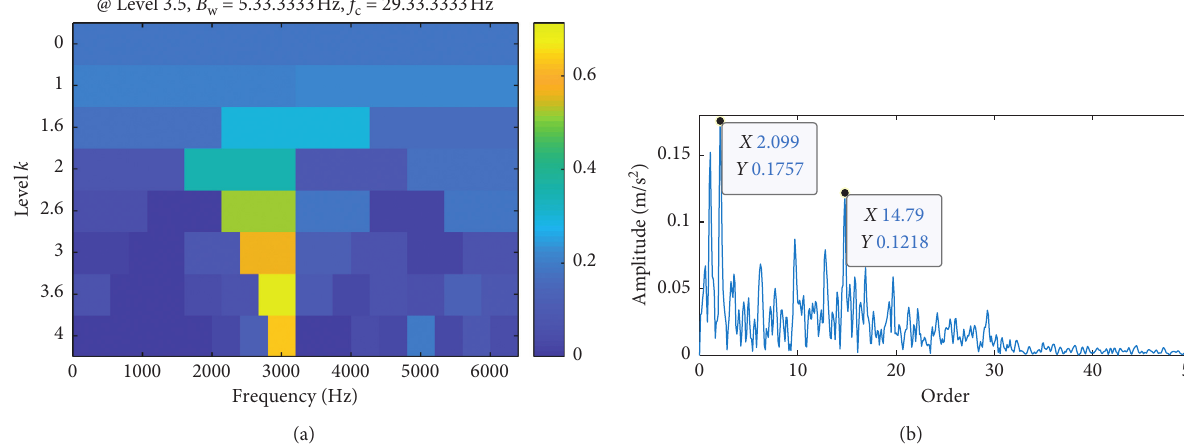
Figure 14: The analysis results using NEA: (a) kurtogram; (b) envelope order spectrum: the spectrum is obscure, and SNR2 is only − 9.07dB.